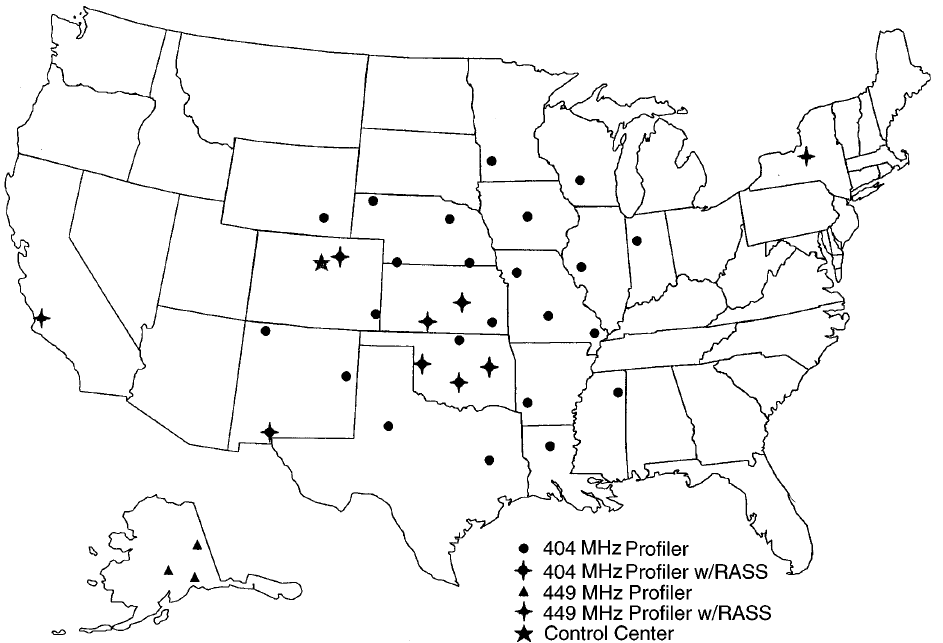
Fig. 8. The locations of the NOAA Profiler Network stations in 1997 (from Chadwick and